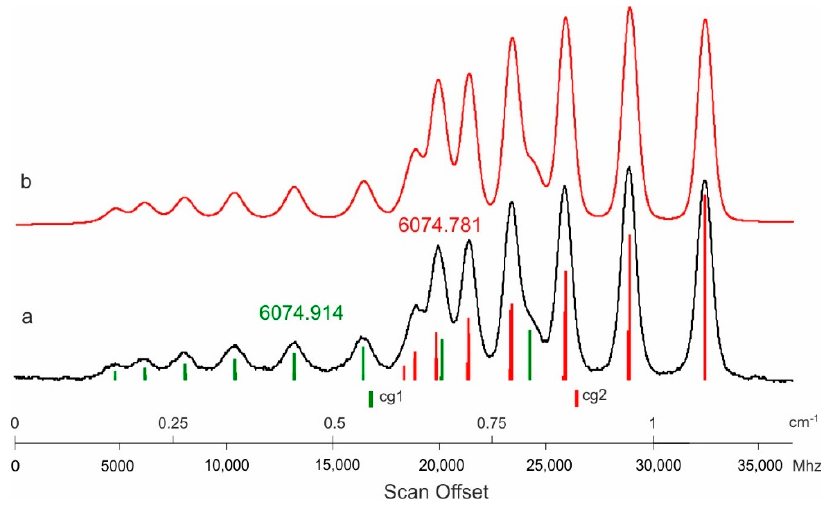
Figure 5. Blend situation around 6074.8 Å. (a) OG record. (b) Fit. See text for